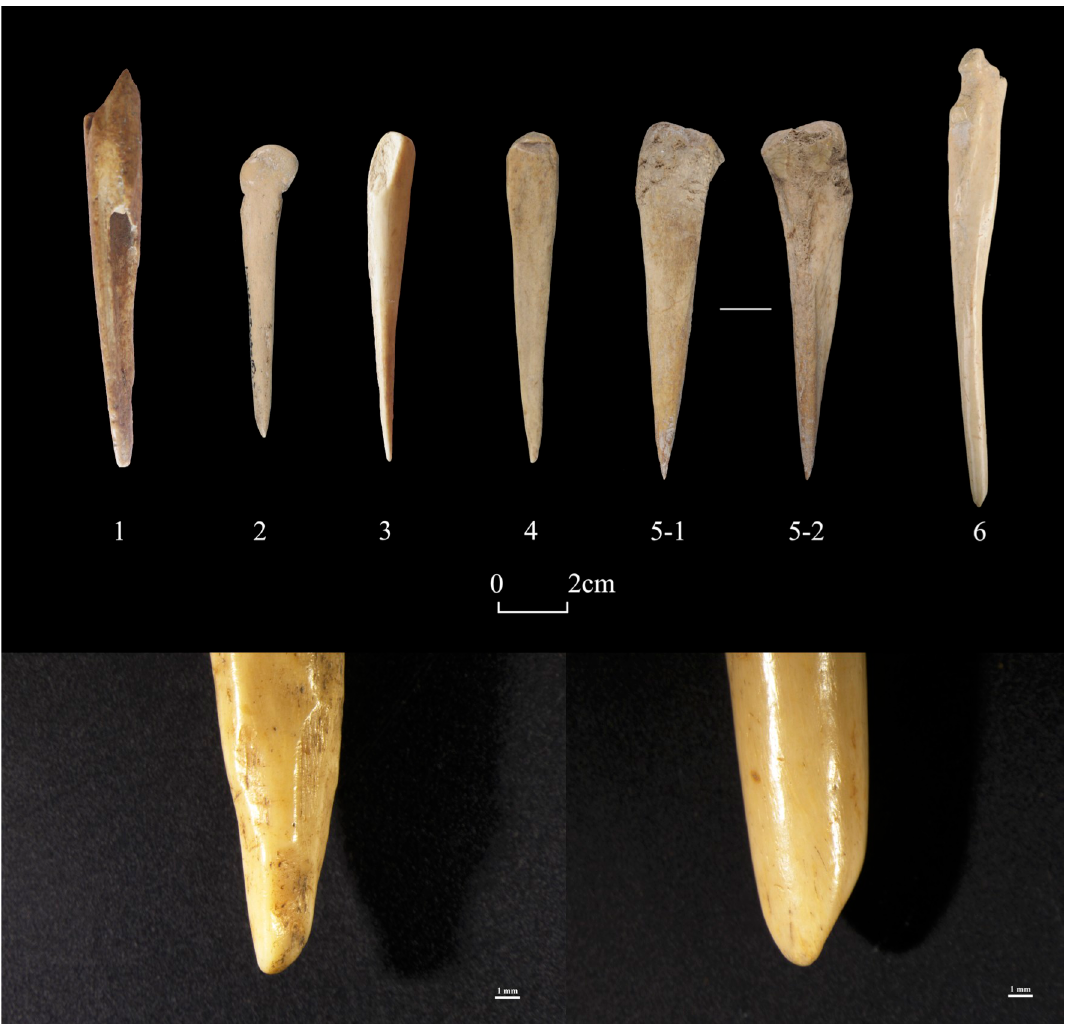
Fig 6. Examples of bone awls from Shirenzigou. 1) specimen from 12XBSIIIH015; 2) specimen from 2010HBSIIIT0619III ② ; 3) specimen from 12XBSIIIF003; 4) specimen from 2009HBSIIIT0719 ① ; 5) specimen from 11XBSIIIT0720IV-2 ② ; 6) specimen from 2010HBSIIIT0720I ③ . The close-ups at the bottom show polished tips of the awls (Left: specimen from 2009HBSIIIT0719 ① ; Right: specimen from 2010HBSIIIT0720I ③ ).